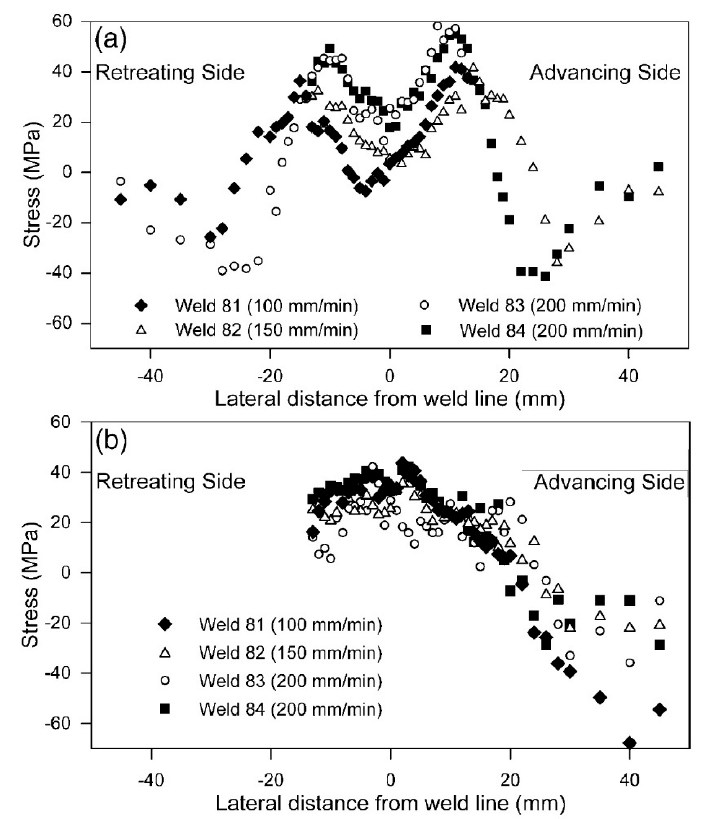
Figure 11. ( a ) Longitudinal and ( b ) transverse residual stresses as a function of welding speed lateral distance from the weld line for each weld [25]. Reprinted from: Microstructure, mechanical properties, and residual stresses as a function of welding speed in aluminum AA5083 friction stir welds. Acta materialia 51, no. 16 (2003): 4791–4801, Peel, M., A. Steuwer, M. Preuss, and P. J. Withers, Copyright 2003, with permission from Elsevier.